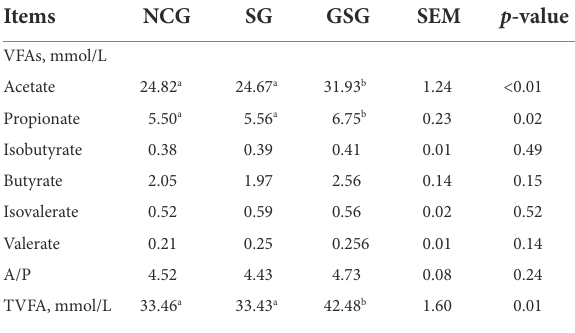
TABLE 2 Volatile fatty acids (VFAs) composition affected by different nutrient simulations.